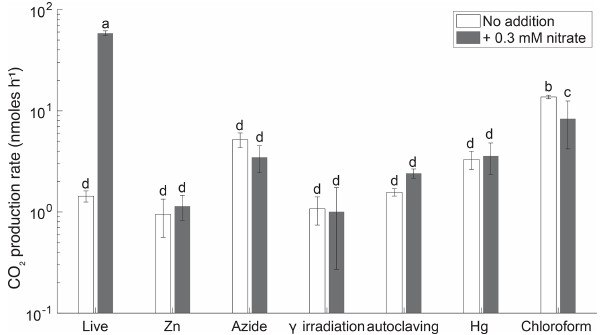
Figure 2. CO 2 production rates in 3d soil slurry incubations of Quistococha peat soil amended with and without 0.3mMNO − ror bars are 1 SD ( n = 3). Columns marked with the same letter are not statistically different from each other (Student’s t test, p > 0 . 05, n = 3). The x axis represents treatments, as in the legend of Fig. 1. Figure 3. Changes in extractable Fe 2 + (left) and Fe 3 + (right) con-